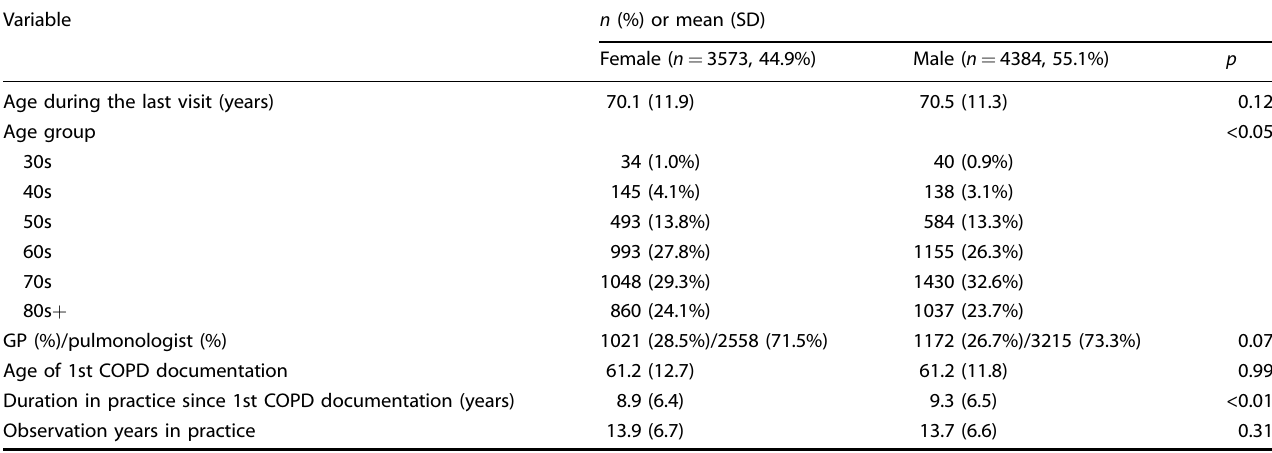
Table 1. Characteristics of 7957 COPD patients by gender.